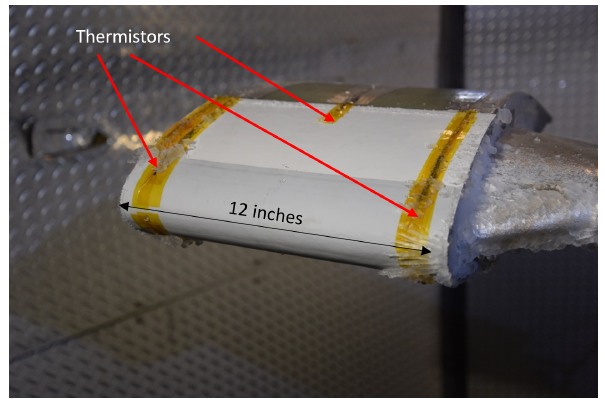
Figure 7. Rotor test